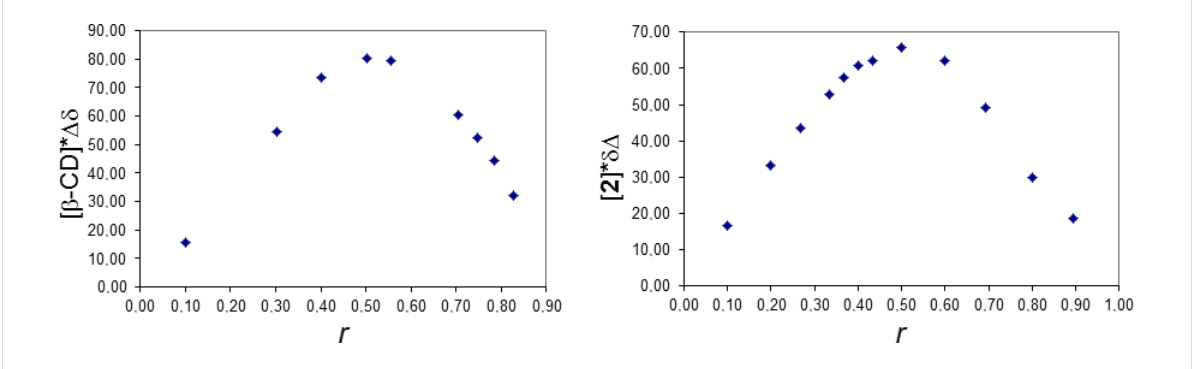
Figure 2: Left: Job’s plot for H3’ chemical shift variations of the complex β -CD/ 1 . Right: Job’s plot for H11 (see Figure 1 for atom numbering) chemi- cal shift variations of the complex β -CD/ 2 .